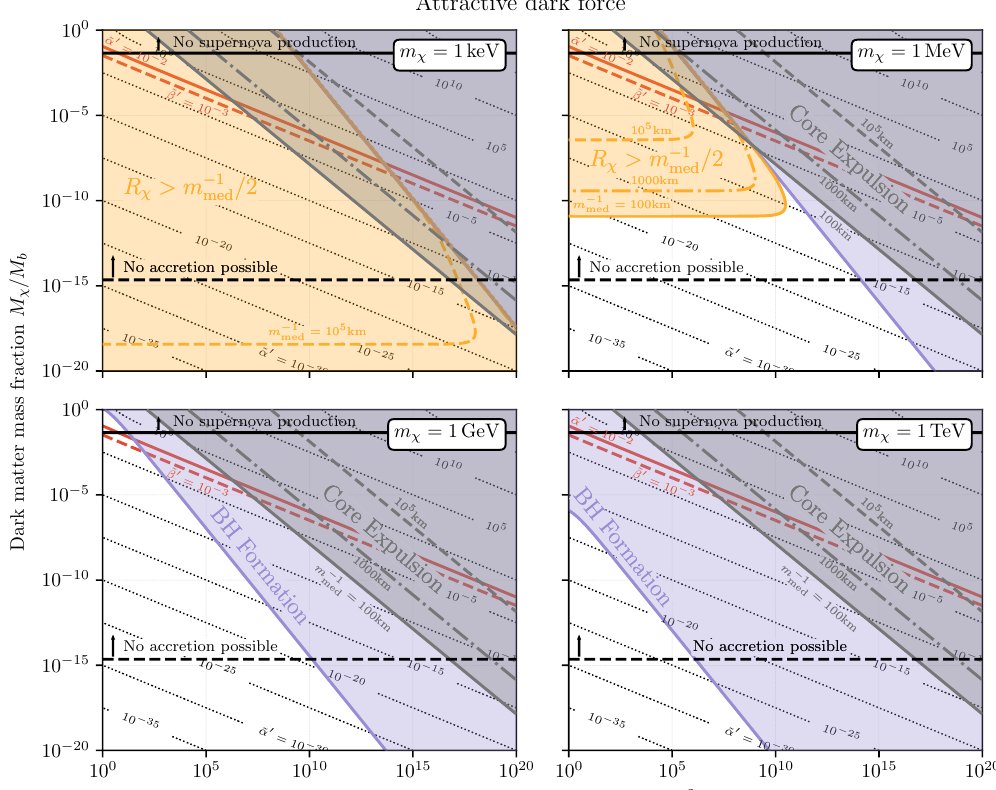
Figure 5 . Constraints on an attractive dark force from binary neutron star systems as a function of the dark (cid:12)ne structure constant (cid:11) 0 (expressed here relative to the gravitational force) and the amount of DM bound to the neutron stars (assuming both stars carry the same amount of DM). The four panels correspond to di(cid:11)erent choices of the DM mass m (cid:31) , as indicated in the plots. The dotted contours show the value of e (cid:11) 0 (in the case of neutron stars with equal dark charge-over-mass ratio) or e (cid:12) 0 (for the case that only one neutron star carries a dark charge, see eq. (2.2)) at each point in the plot. We indicate in red the estimated minimum value of e (cid:11) 0 or e (cid:12) 0 required for the dark force to leave an observable imprint in LIGO data. In the purple region, the dark force induces collapse of the neutron stars’ dark cores to black holes. Inside the gray shaded region, the dark cores are expelled from the neutron stars as soon as the screening of the force is lifted. We show this region for m (cid:0) 1 = med 100 km (solid), 1000 km (dot-dashed), and 1 (cid:2) 10 5 km. Bounds shown in black are model-dependent: in the region above the black-dashed line, the DM population inside the neutron cannot be generated by capture from the halo, based on the geometric arguments that lead to eq. (3.12). Above the solid black line, the hypothesis that the DM population is produced radiatively during the supernova that created the neutron star is not tenable because the energy available in a supernova (as measured in SN 1987A) is not su(cid:14)cient. Within the yellow regions, the DM particles would be stripped away from their host neutron star before they can have a signi(cid:12)cant impact on the inspiral. The bench- mark values of m (cid:0) 1 are the same as for the gray DM expulsion bound. The neutron star parameters med are chosen in accordance with table 1, and without loss of generality we have chosen q (cid:31) =